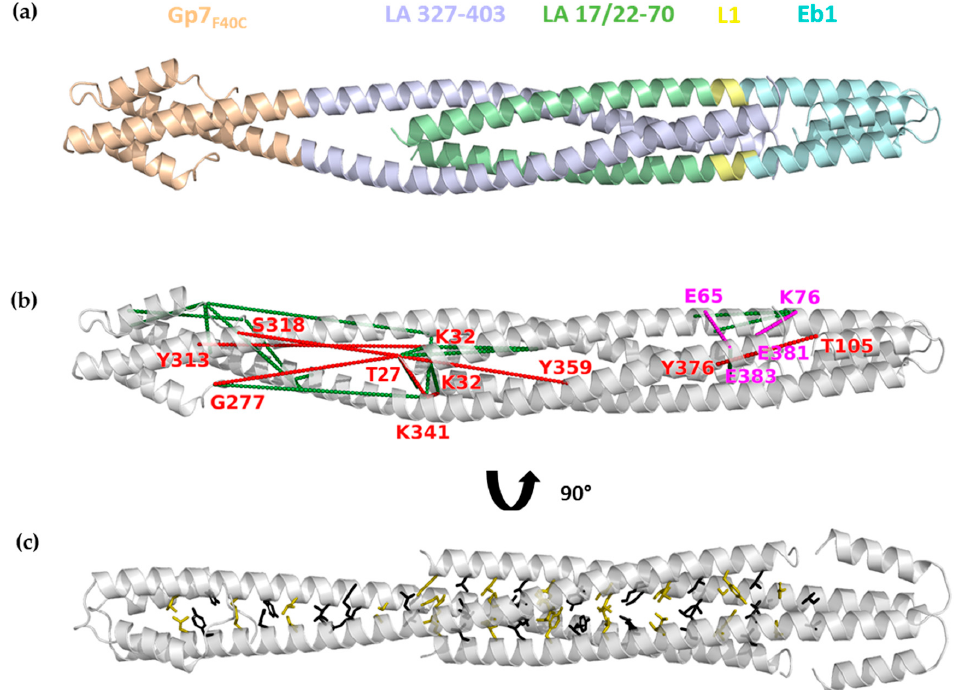
Figure 8. Modelling of the A CN tetramer. ( a ) Final molecular model of the A CN tetramer. Gp7 F40C -LA 327-403 is coloured wheat (Gp7 F40C ) and blue (LA 327-403). LA 17-70-Eb1 is coloured green/yellow (LA 17-70) and cyan (Eb1). ( b ) Final molecular model of the A CN tetramer with all 31 cross-links that were compatible with the model . Interdimer cross-links are coloured green. Tetramer cross-links are labelled and coloured red (DSBU, DSPU and DSG) and magenta (EDC). ( c ) Rotated view of the model with the hydrophobic core residues shown as sticks (‘a’ and ‘d’ positions in black and olive, respectively).